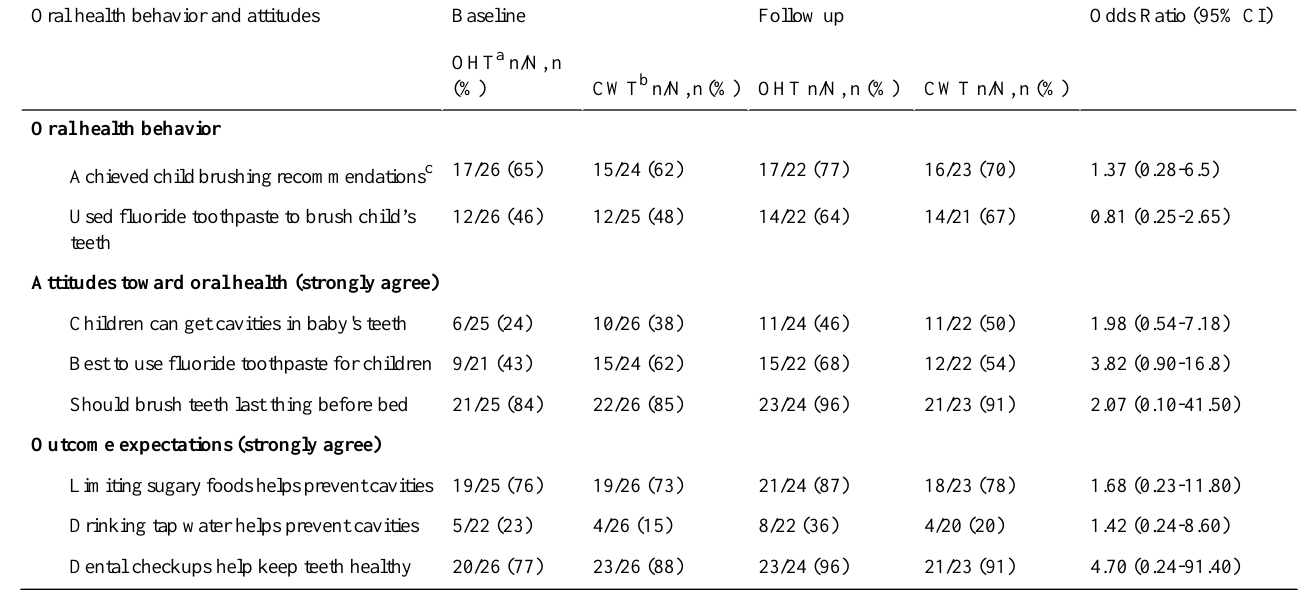
Table 4. Oral health behaviors and